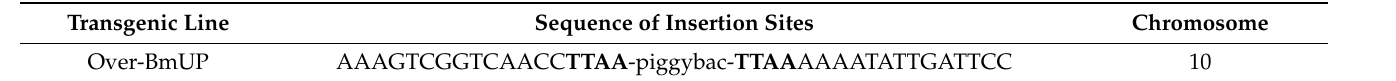
Figure 3. Establishment of Over-BmUP transgenic strains. ( a ) The transgenic expression vector pBac[3 xp3-DsRed, A4-BmUP-SV40] was constructed to overexpress Bombyx mori BmUP . The promoters were 3 xp3 and A4, and SV40 was used to stop transcription. DsRed is a Red Fluorescent Protein. ( b ) Fluorescence images of G1 eggs and moths for transgenic BmUP overexpression and wild type (WT) strains. The signal of DsRed in the transgenic strain is indicated with white triangles. ( c ) Relative mRNA levels of BmUP were investigated by qRT-PCR in the testis and ovaries in overexpressing individuals and wild-type individuals (*** p < 0.001, ** p < 0.01). ( d ) Immunoblot analysis of BmUP according to the Flag-tag. Table 1. Insertion site of Over-BmUP strains. Table 2. Insertion site of Over-BmUP